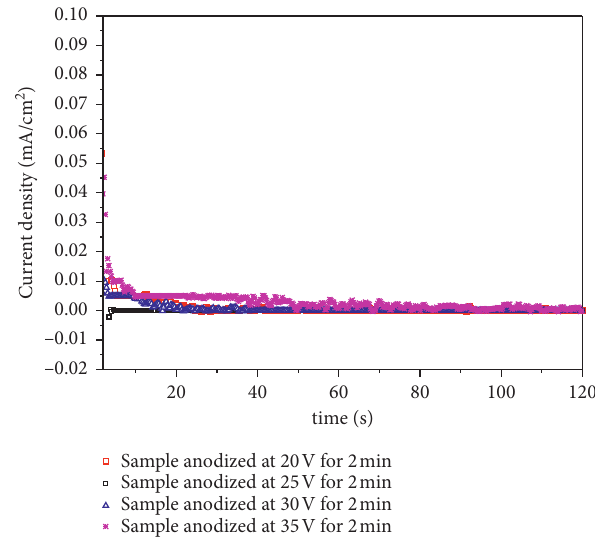
Figure 1: Chronoamperometric curves obtained at different ap- plied potential during 2min, in 5M phosphoric acid.